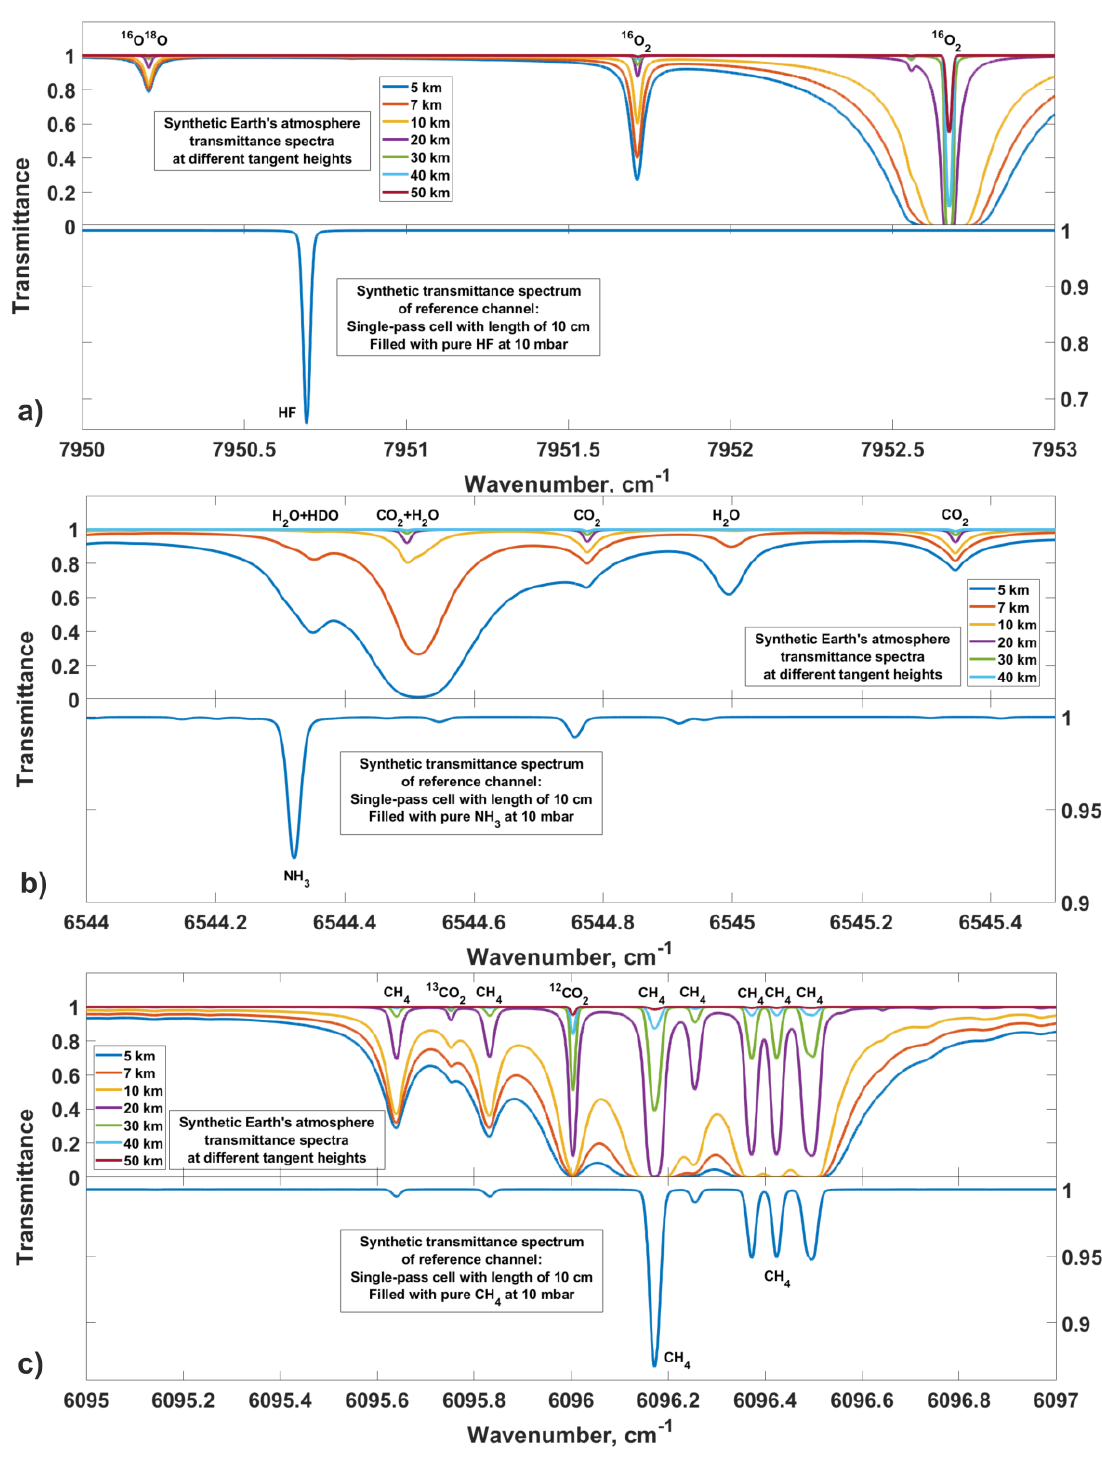
Figure 14. Synthetic transmittance spectra of the Earth’s atmosphere for different tangent heights in three spectral channels (upper subplots) and transmittance in corresponding reference channels (lower subplots). ( a ) The 1258 nm (7951.5 cm − 1 ) spectral range with the atmospheric O 2 lines in the range of 5–50 km; reference channel transmittance of HF (hydrogen fluoride) with the optical path of 10 cm and at a pressure of 10 mbar. ( b ) The 1528 nm (6544.5 cm − 1 ) spectral range with the atmospheric H 2 O and CO 2 lines in the range of 5–40 km; reference channel transmittance of NH 3 with the optical path of 10 cm and at a pressure of 10 mbar. ( c ) The 1640 nm (6096 cm − 1 ) spectral range with the atmospheric CH 4 and CO 2 lines in the range of 5–50 km; reference channel transmittance of CH 4 with the optical path of 10 cm and at a pressure of 10